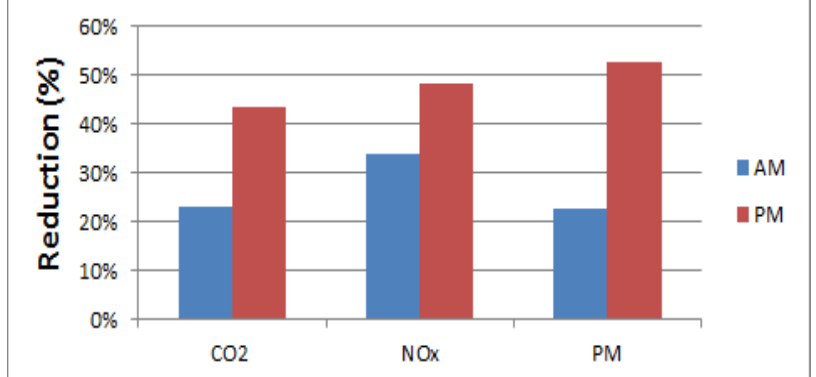
Figure 8. Impacts of emissions of campus related trips